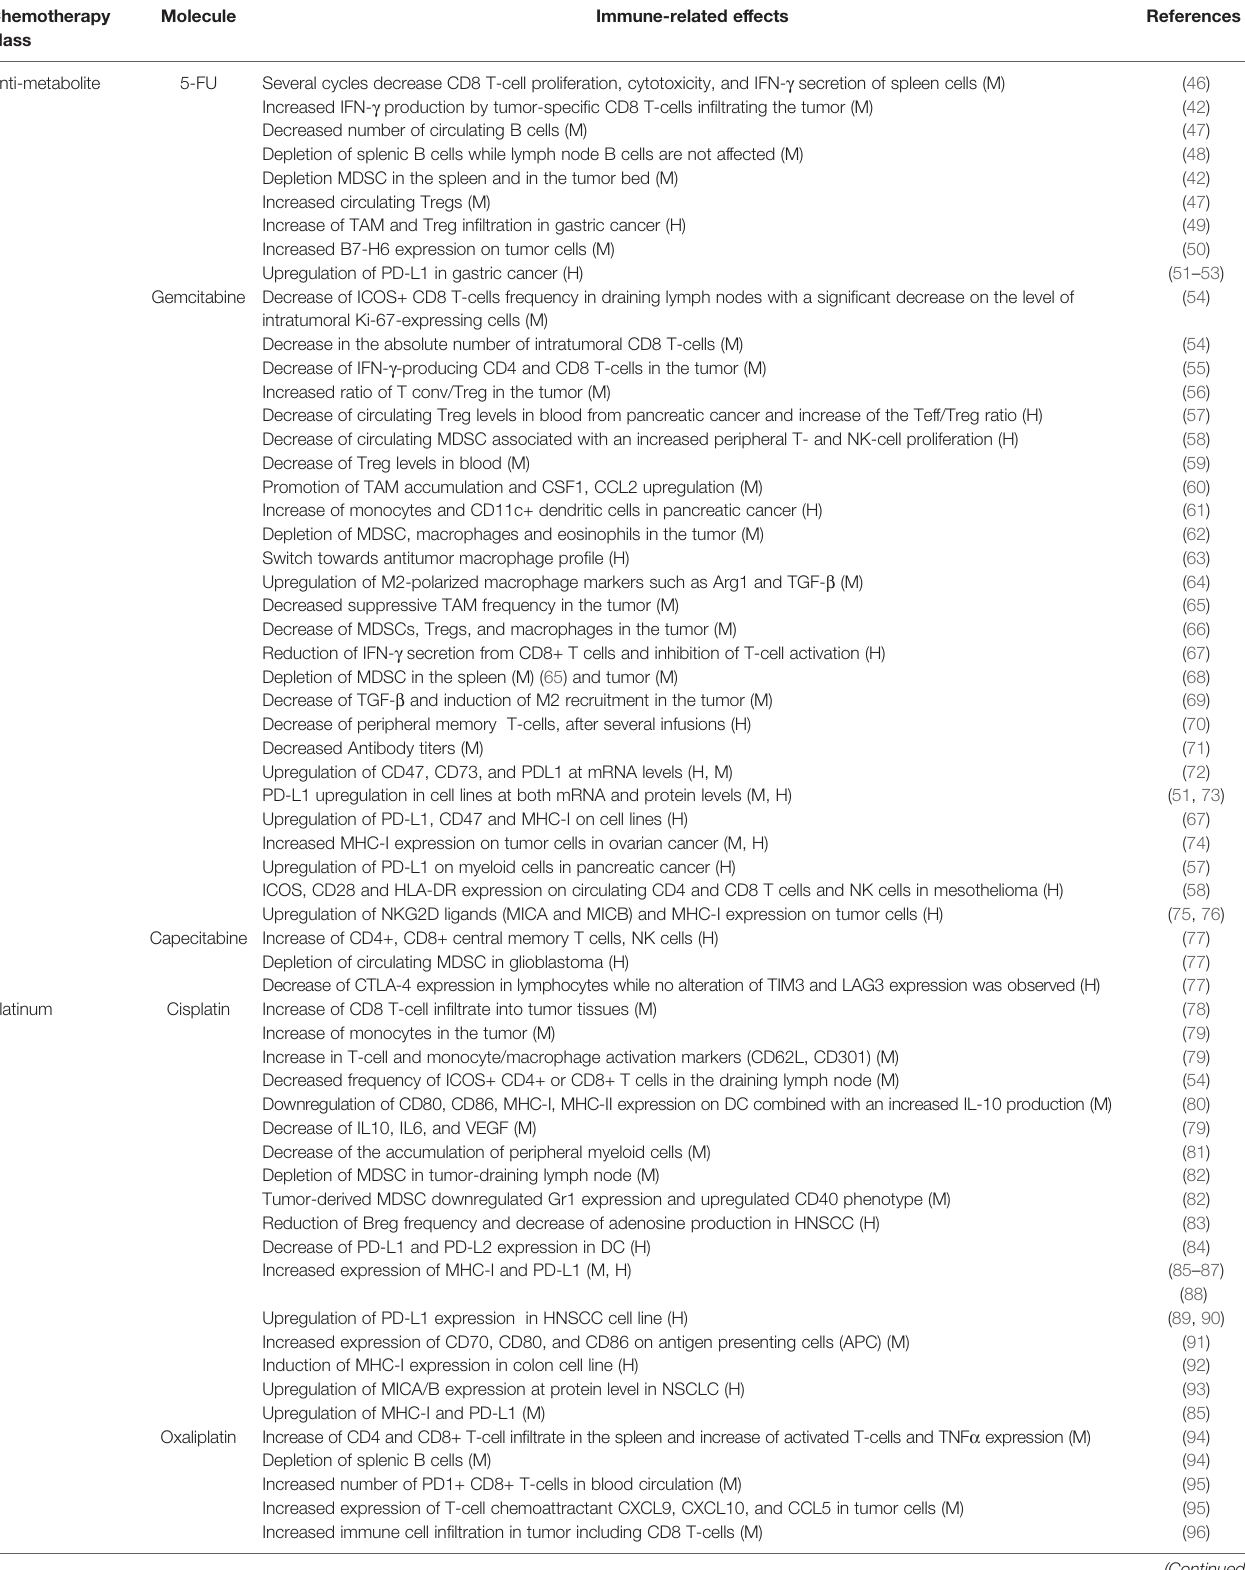
TABLE 1 | Immunomodulatory effects of chemotherapeutic agents used for the treatment of pancreatic ductal